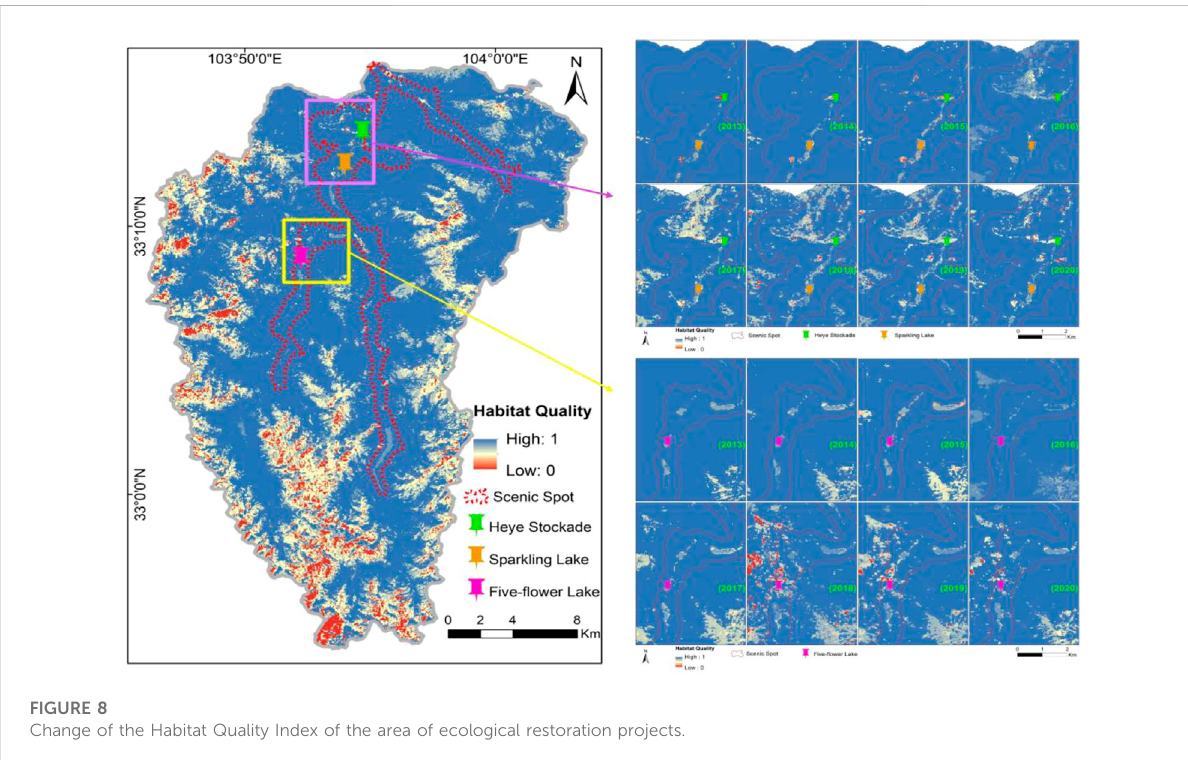
FIGURE 8 Change of the Habitat Quality Index of the area of ecological restoration projects.